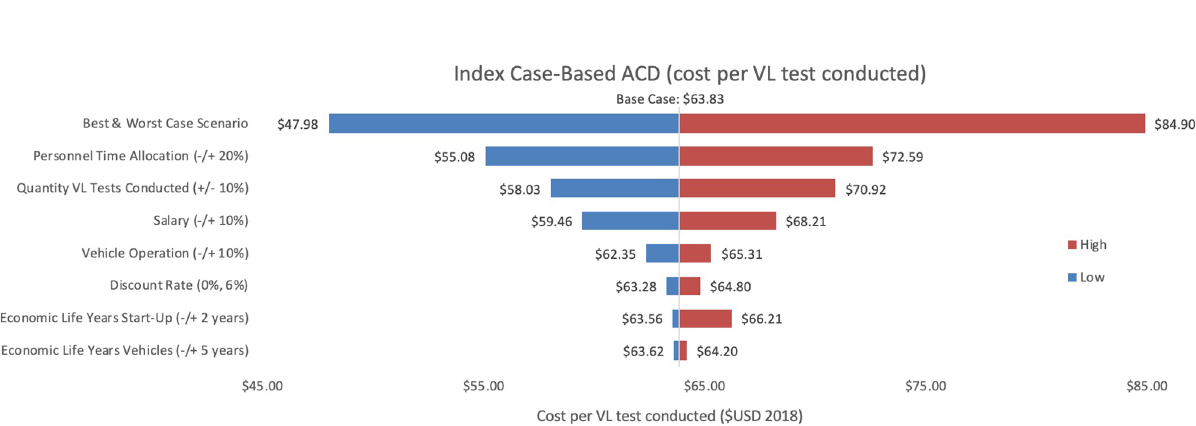
Fig 4. Sensitivity analysis of index case-based ACD per VL test conducted. Variations in index case-based ACD cost per VL test conducted in Bihar during 2018.